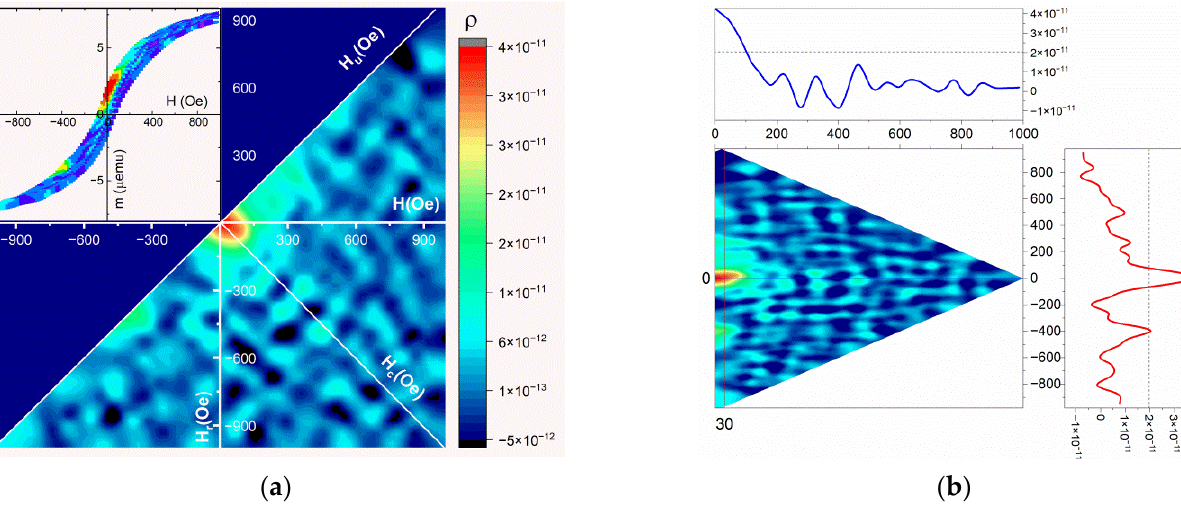
Figure 5. ( a ) Resulting FORC-diagram with an averaging factor of 100 for a system of α -FeSi 2 nanorods on a Si(111)-4° surface; a set of FORC curves is presented in the inset. The ρ value is color-coded; ( b ) rotated FORC-diagram and profiles along H U and H C axes.